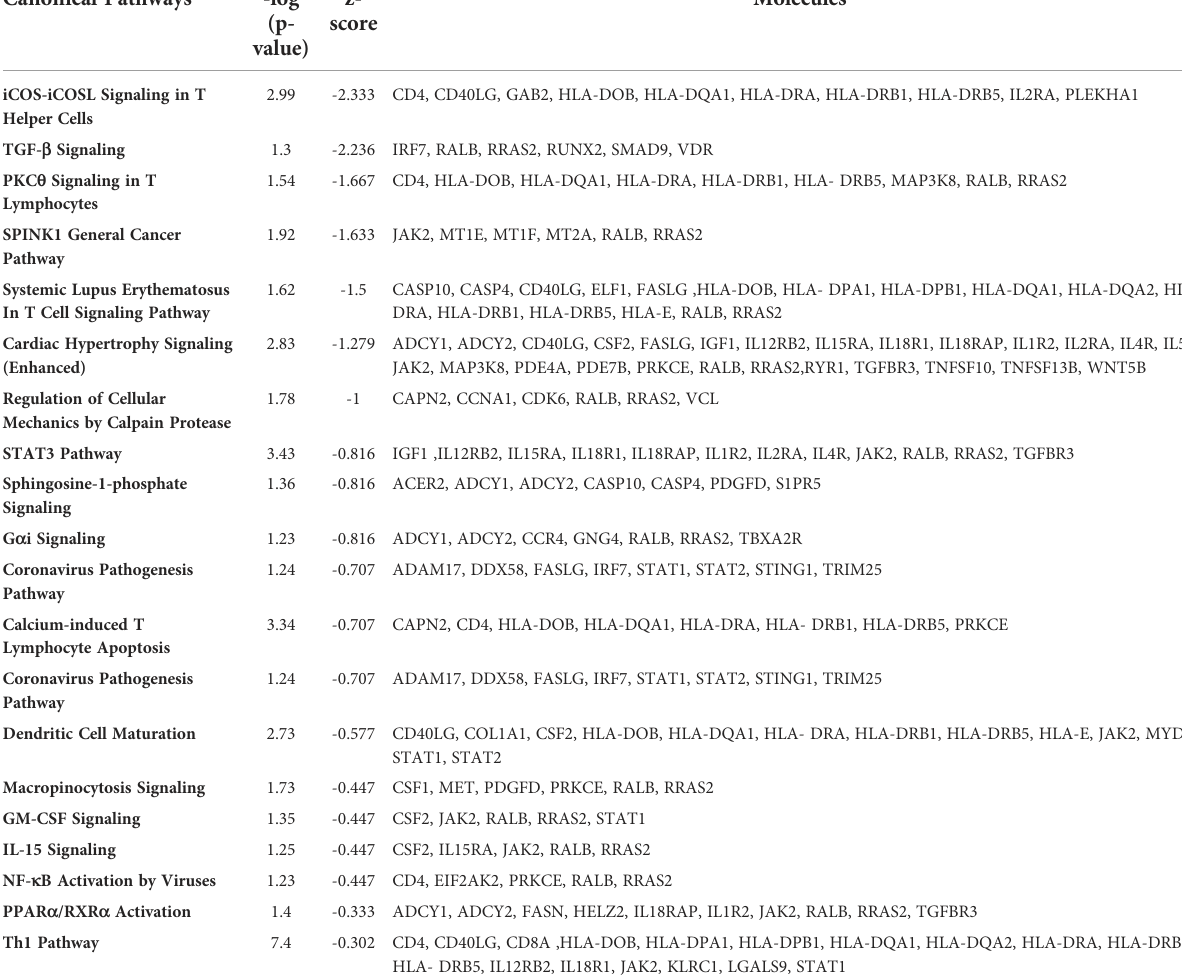
TABLE 2 Canonical pathways with negative Z-score. Canonical Pathways -log